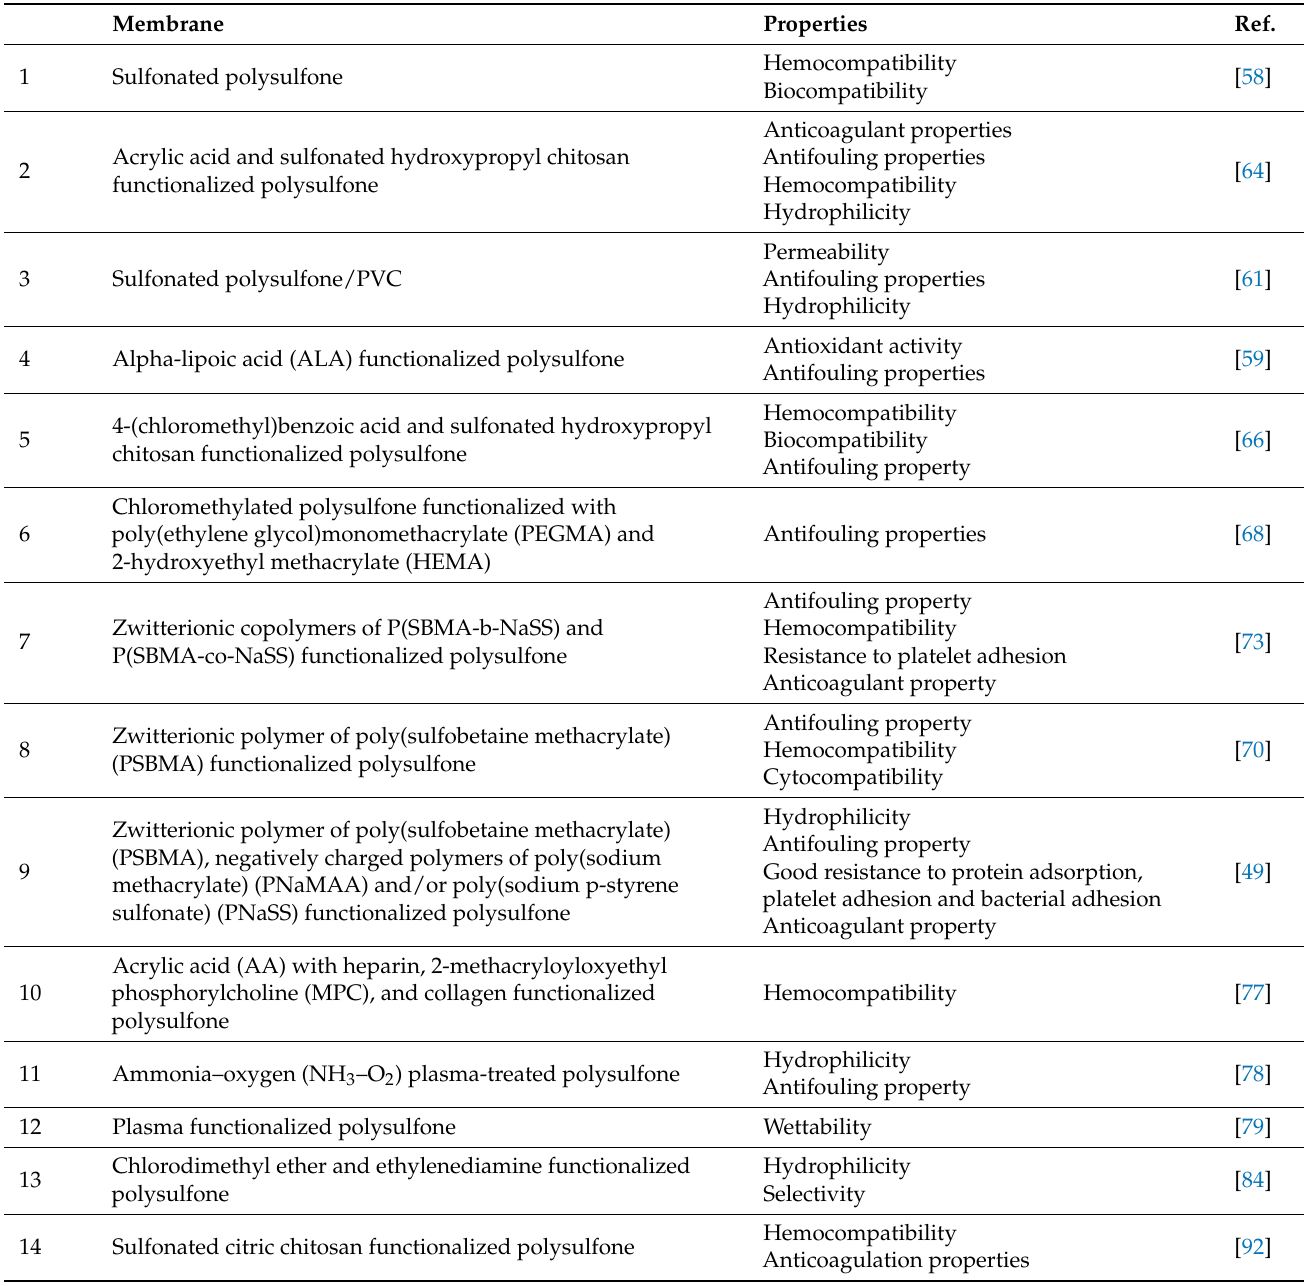
Table 1. Functionalized membrane and induced